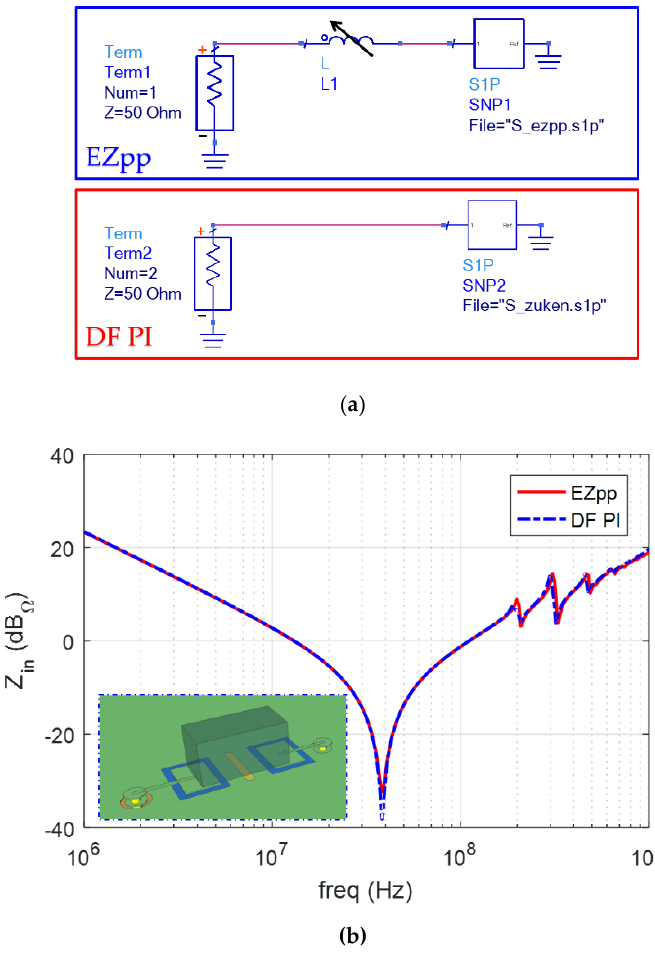
Figure 3. ( a ) Circuits used in ADS for tuning the inductance L1 in order to match Z in , without decaps, from EZpp with the one from DF PI, getting the profiles shown in ( b ). The inset shows how a component, in this case a capacitor, is represented by DF PI with traces and vias creating the connection with PWR and GND planes.